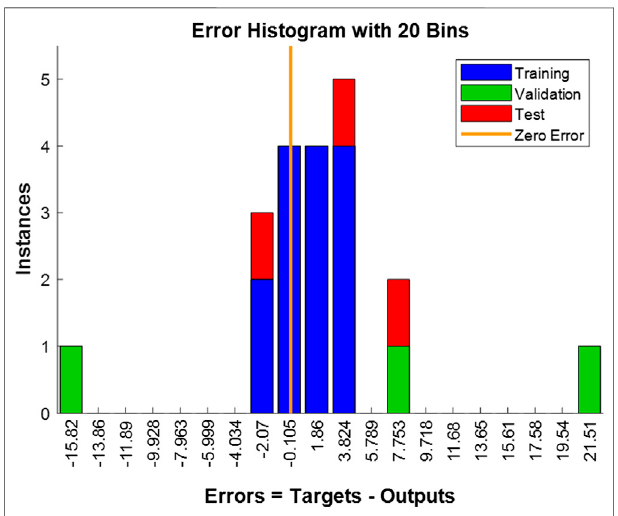
FIGURE 10 | Error histogram of the selected network.